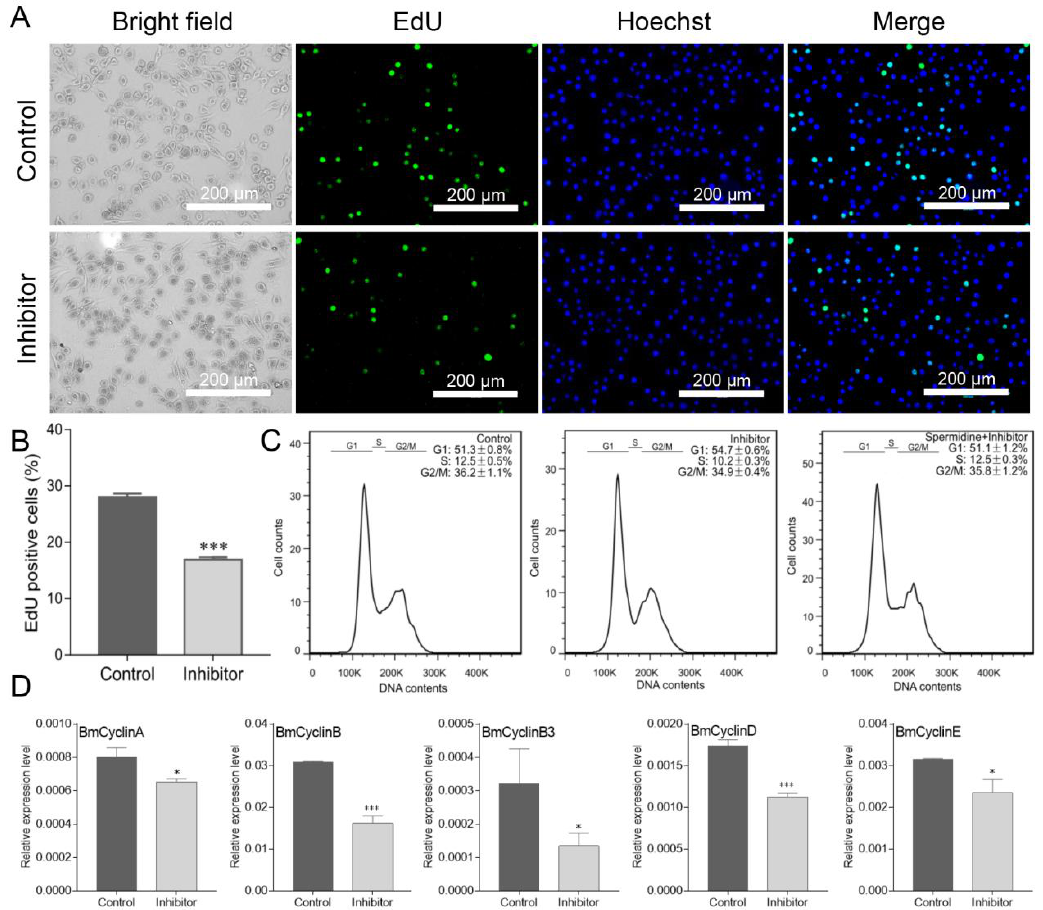
Figure 5. Inhibition of polyamine pathway activity decreased DNA replication in cultured silkworm cells. ( A ) BeyoClick™ EdU-488 staining was used to detect DNA replication. Scale bar, 200 μm. ( B ) EdU-positive cells (green) were analyzed by selecting three different fluorescent fields and counted by Photoshop software. The data presented are the means ± SD ( n = 3). ( C ) Cell cycle distribution was analyzed by using a flow cytometry and cells in G1, S, or G2/M were quantitated by FlowJo software. Three repeats were done for each treatment and the percentage of cells are the means ± SD ( n = 3). ( D ) Expression of cell cycle-related genes was detected by qRT-PCR. For significant analysis: * p < 0.05 and *** p < 0.001.